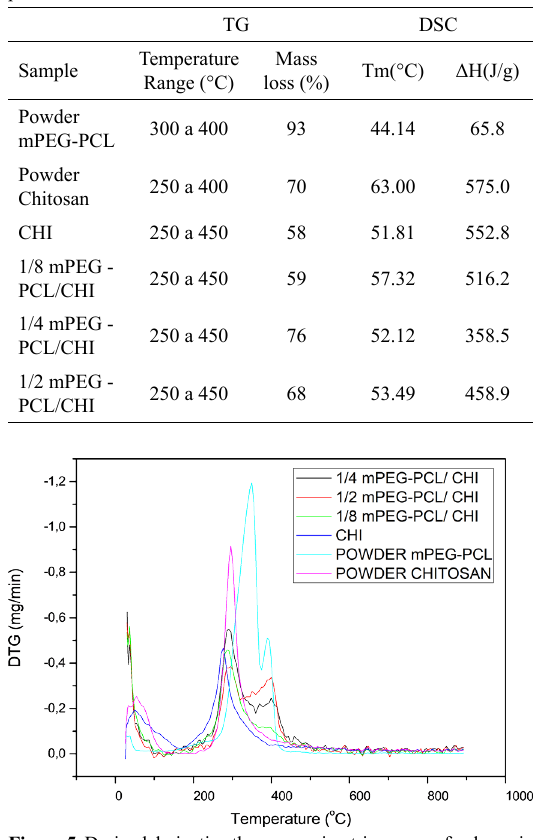
Figure 5. Derived derivative thermogravimetric curves of polymeric raw materials and membranes unloaded with gentamicin. (pink) chitosan, (light blue) mPEG-PCL, (blue) CHI, (green) 1/8 mPEG-PCL/ CHI, (black) 1/4 mPEG-PCL/CHI and (red) 1/2 mPEG-PCL/CHI.